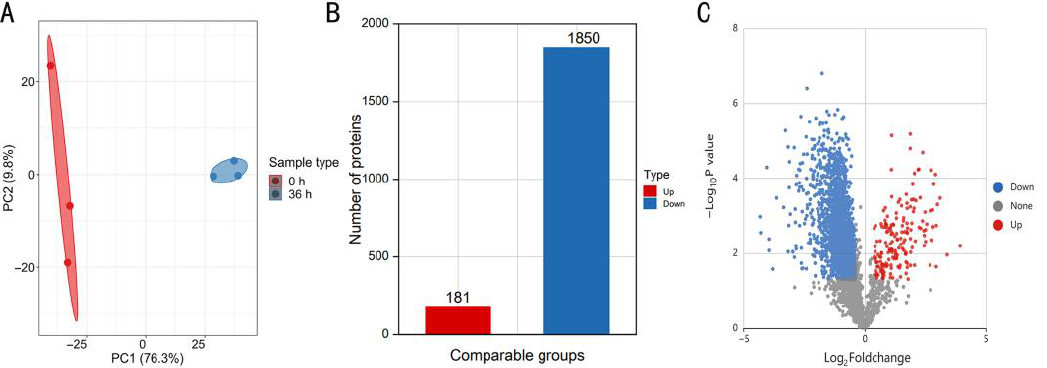
Figure 1. Overview of protein identification and sample repeatability test. ( A ) Principal component analysis (PCA) showed quantitative sample repeatability, ( B ) histogram of the protein number distribution of differentially expressed proteins (DEPs) in different comparison groups, and ( C ) volcano plot of DEPs in the groups being compared (|log 2 Fold Change| > 1.3 and p < 0.05). Table 1. Proteins whose expression was upregulated by more than 5-fold in the proteomic data. Protein ID a Protein